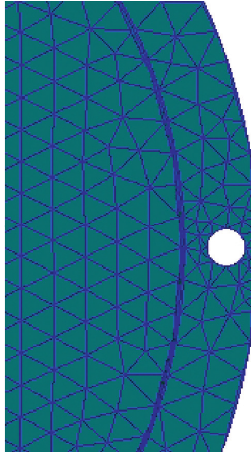
Figure 23: Zoomed image of the FE model. Figure 24: Groups of updating areas of the cover